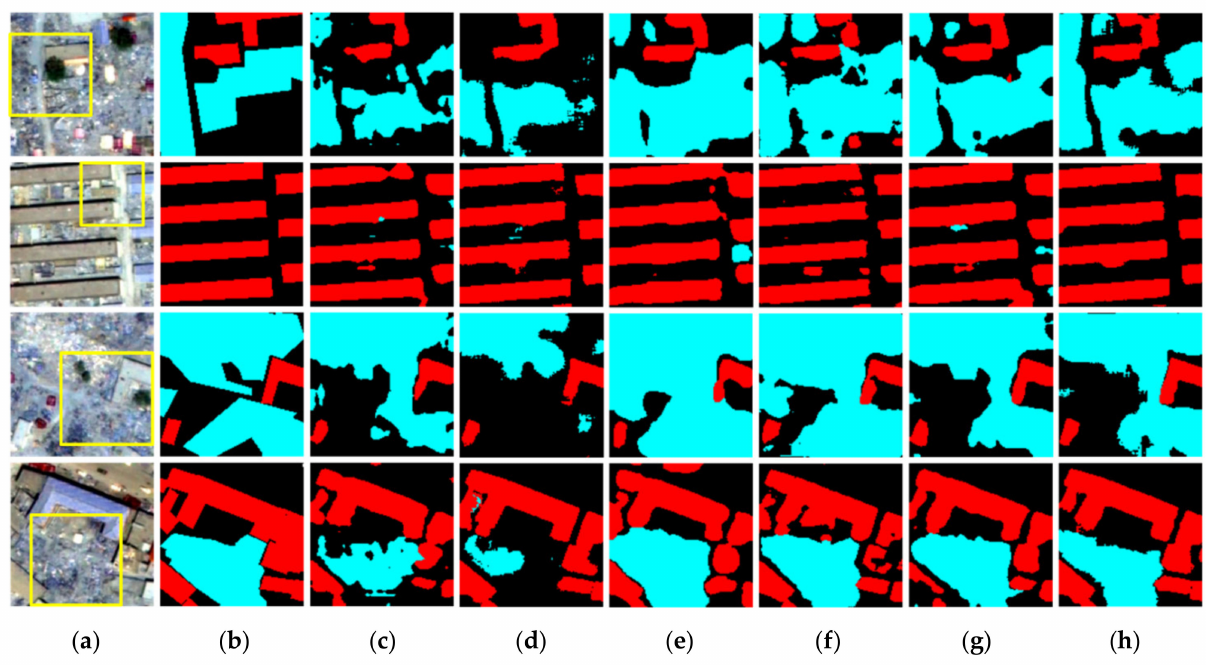
Figure 9. Detection results of the YSH dataset by different networks: ( a ) original image; ( b ) ground truth map; ( c ) DeepLabv3+; ( d ) UNet; ( e ) MobileNetV2+CA; ( f ) UNet 3+; ( g ) OB-DeepLabv3+; ( h ) OB-UNet; red, blue and black in ( b – h ) separately represent non-collapsed buildings, collapsed buildings and the